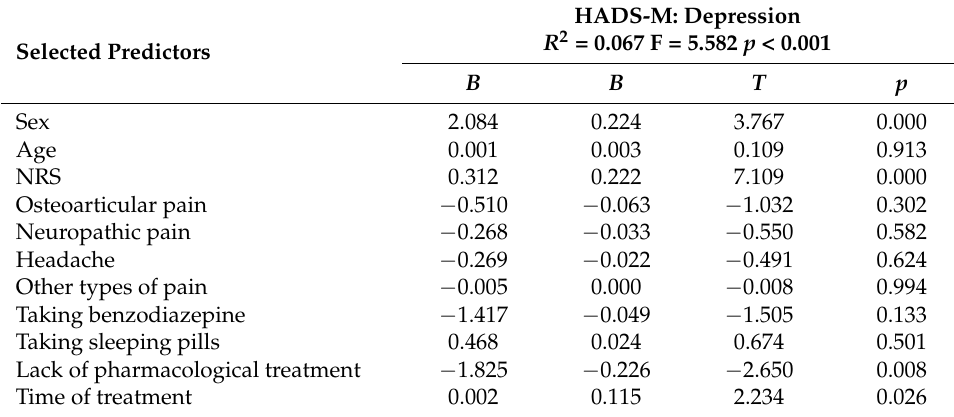
Table 4. Regression Analysis for the HADS-M: